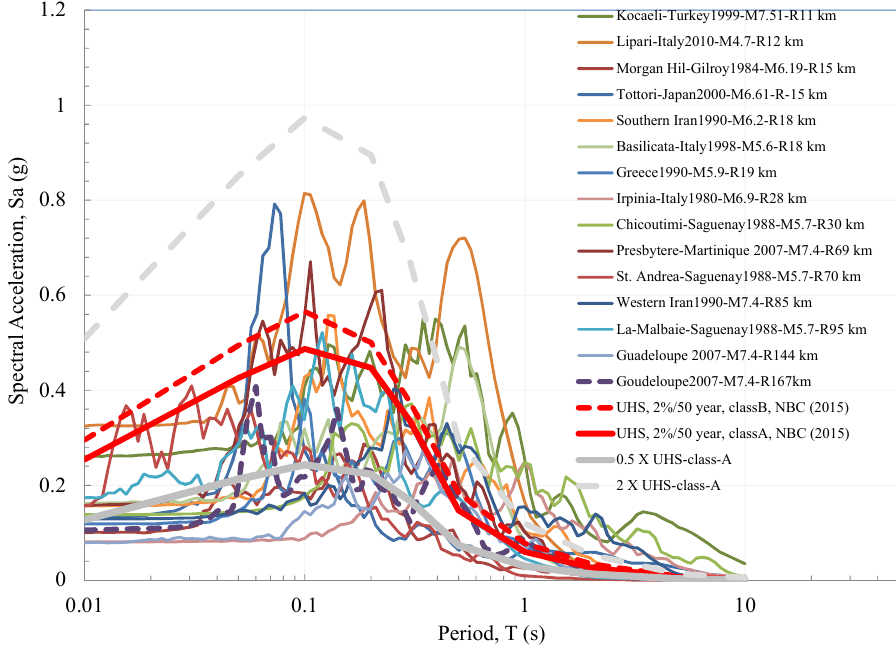
Figure 1. Response spectra (damping ratio of 5%) of selected recorded accelerograms and Uniform Hazard Spectra (UHS) for site classes A and B (National Building Code of Canada (NBCC) 2015).